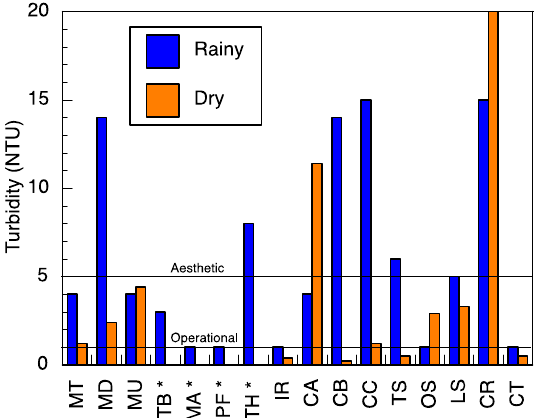
Figure 5. Turbidity of the water sources in the study area. Two to three measurements were taken during an intensive study period from 13 January 2017 to 4 February 2017 in the wet season and three to four measurements from 5 June 2016 to 15 July 2016 in the dry season. The median measurement of the values is reported here. Ephemeral rivers that do not flow all the way into the valley are indicated (*) in the dry season.